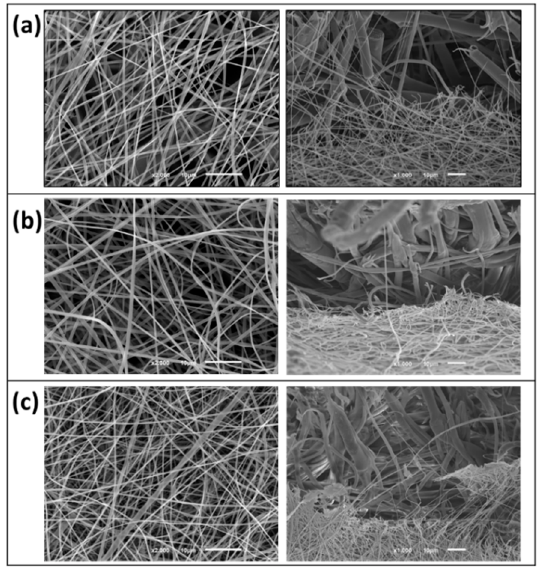
Figure 8. SEM images of the PP microfibres combined with PA nanofibres. The nanofibres were produced for ( a ) 10 min, ( b ) 20 min and ( c ) 30 min.